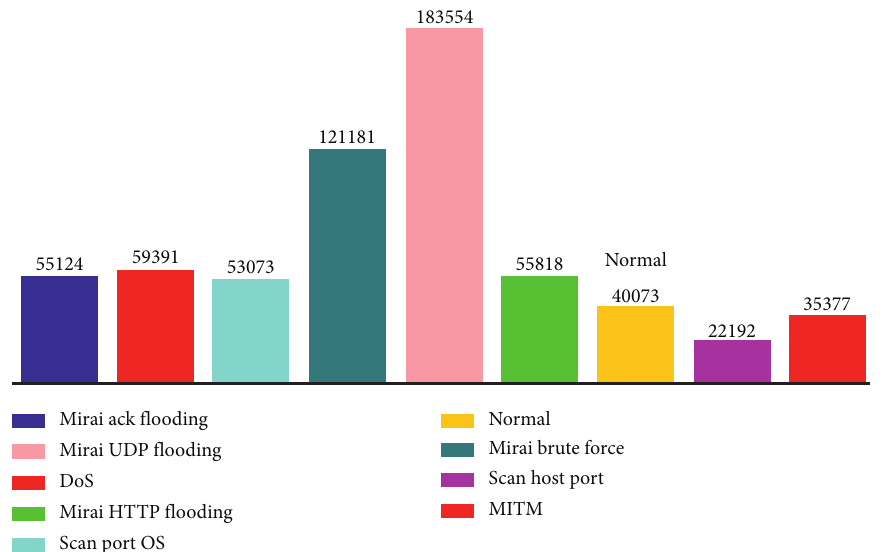
Figure 4: Numbers of instances for each class of IoTID20